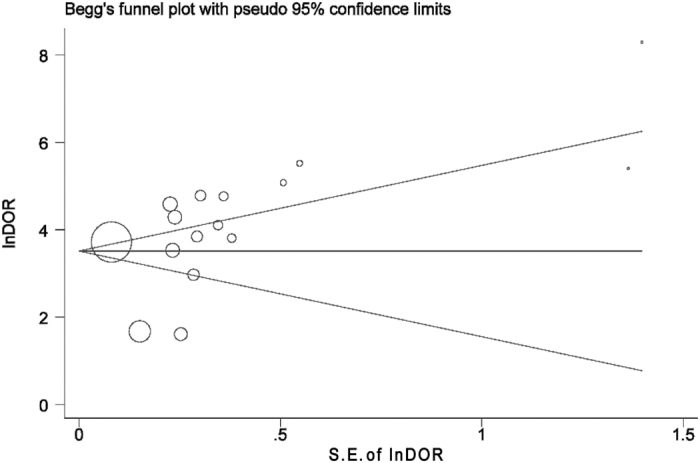
Funnel graph for the evaluation of potential publication bias of selected studies.Symbol size for each study is proportional to the study size. The line in the center indicates the summary DOR.The Egger test for publication bias was not significant.